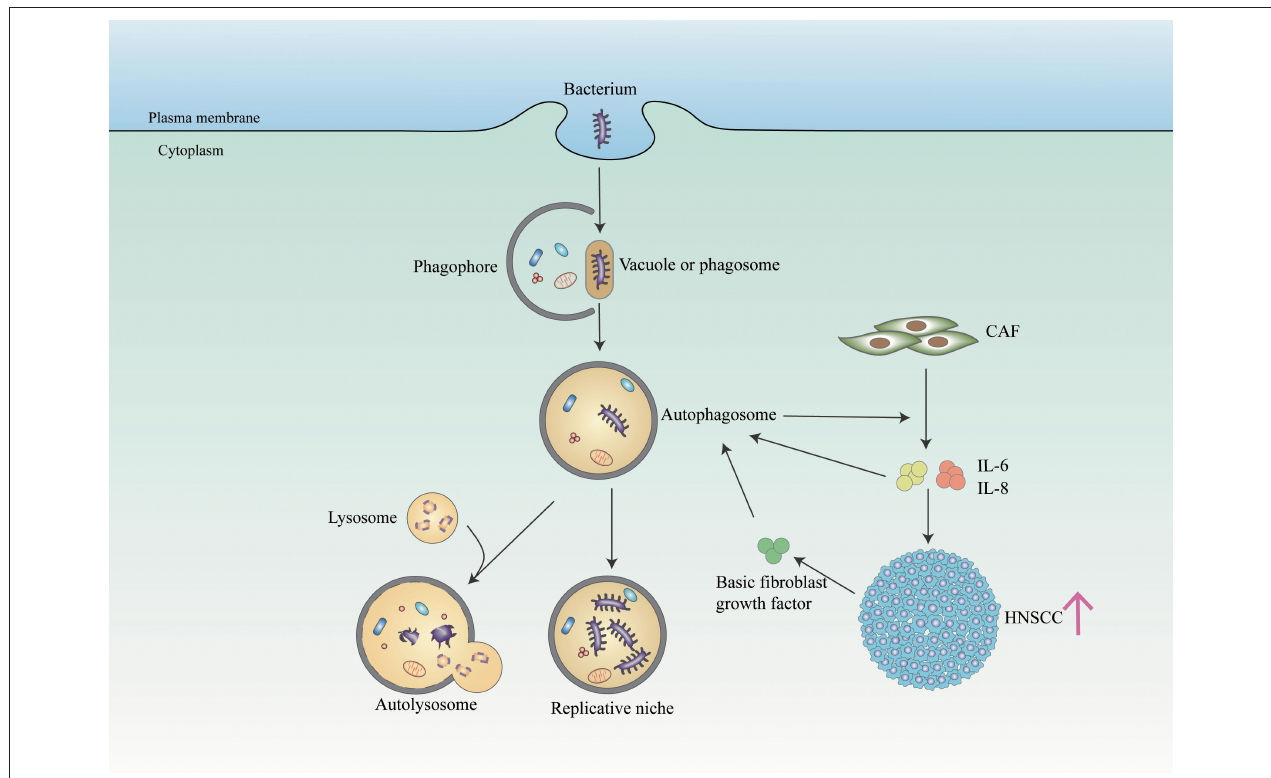
FIGURE 2 | Bacteria and autophagy interplay in cancer cells. The bacterium (such as P. gingivalis ) resides in a bacterium-containing vacuole (or phagosome) after invasion of host cells. Phagophore is assembled and starts to elongate to enclose cytoplasmic components on the stimulation of autophagy to form autophagosome. And autophagosome serves as a replicative niche in which they are not eliminated. In addition, some bacterium toxicity is degraded in the autolysosome generated by fusing autophagosome and lysosome. In NHSCC, autophagy regulates the secretion of IL6 and IL8 from CAFs, facilitating HNSCC migration. And paracrine secretion of IL6, IL8, and basic fibroblast growth factors promotes CAF autophagy, which is further maintained through IL6 and IL8 autocrine